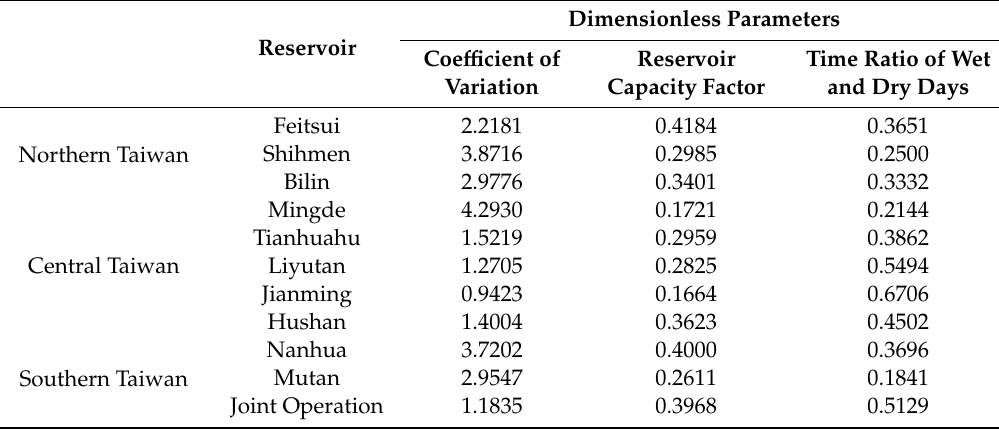
Table 8. The interpretative parameters of the case studies’ local